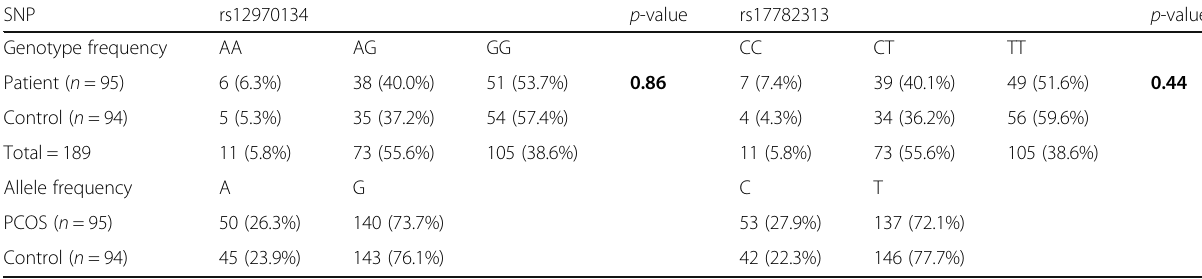
Table 2 Genotype and allele frequencies for MC4R variants rs12970134 and rs17782313